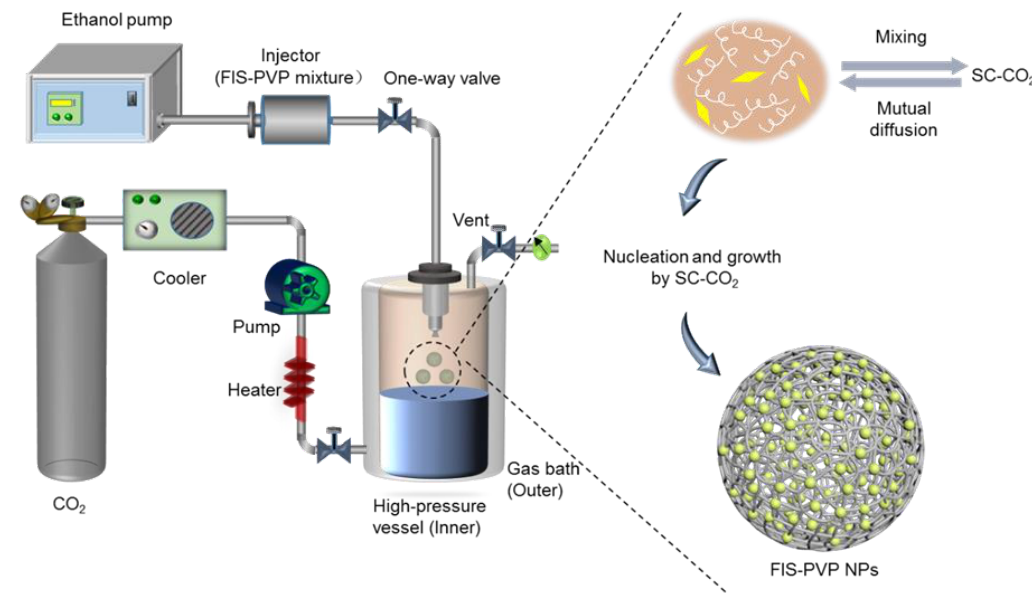
Figure 1. Schematic representation of the supercritical antisolvent (SAS) device set-up for the Figure1. Schematicrepresentationofthesupercriticalantisolvent(SAS)deviceset-upforthepreparation preparation of poly (vinyl pyrrolidone) (PVP)-encapsulated FIS nanoparticles (FIS-PVP NPs). of poly (vinyl pyrrolidone) (PVP)-encapsulated FIS nanoparticles (FIS-PVP